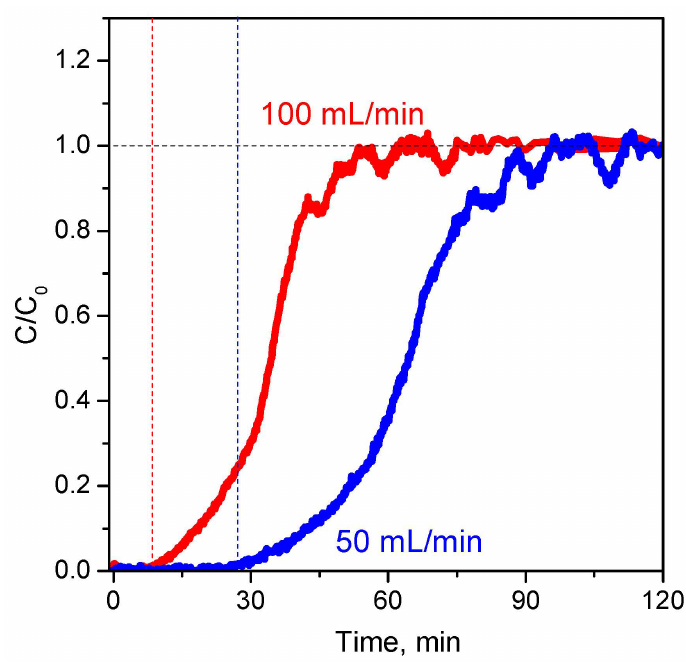
Figure 11. Breakthrough curve of CO on 6.4CuZ27(SE) at flow rates of 50 and 100 mL min − 1